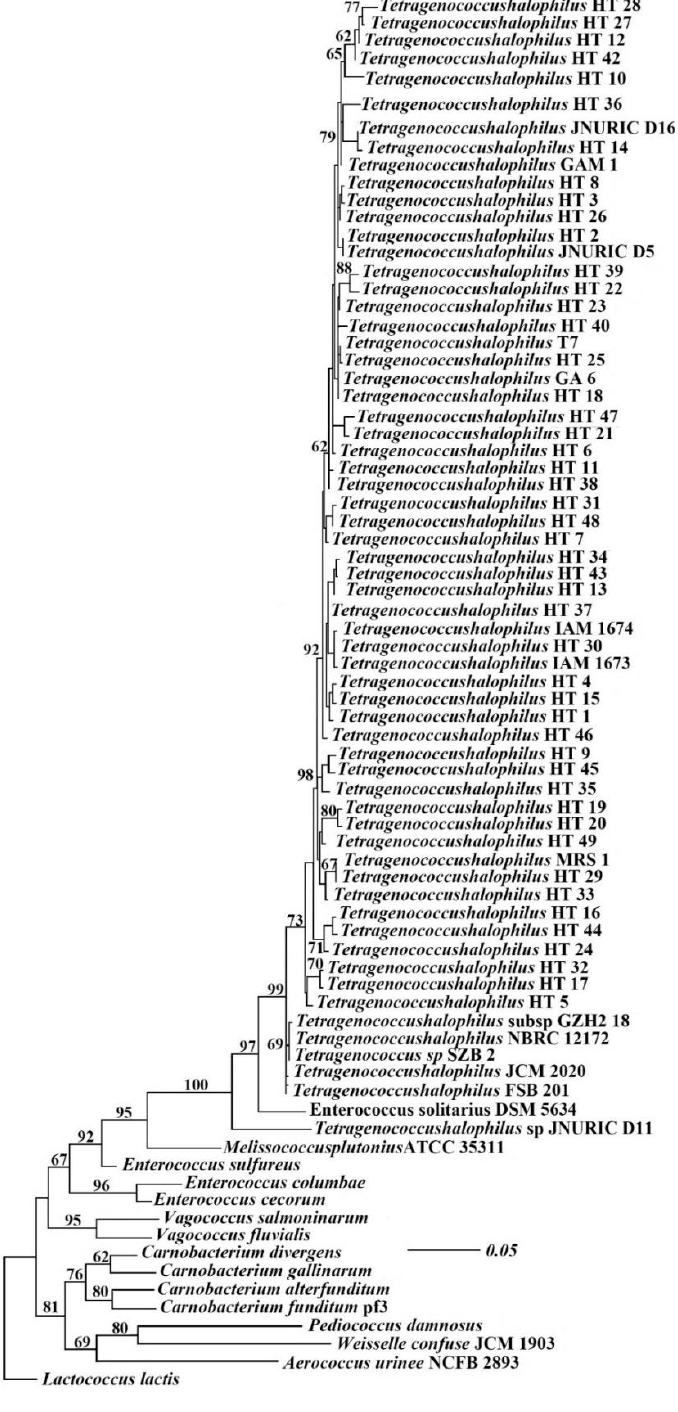
Figure 3. Phylogenetic analysis of 49 strains of T halophilus based on 16S rRNA sequence.